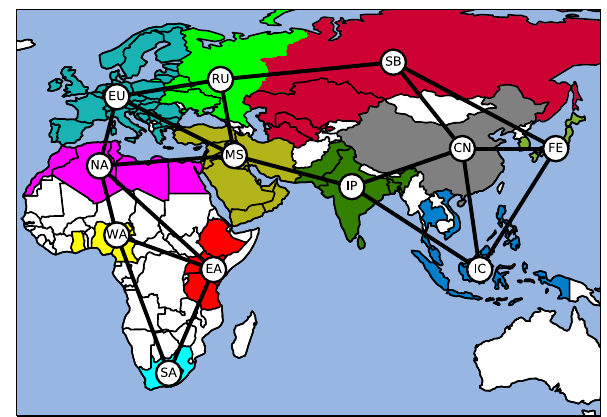
Table 1. Considered regions and their average